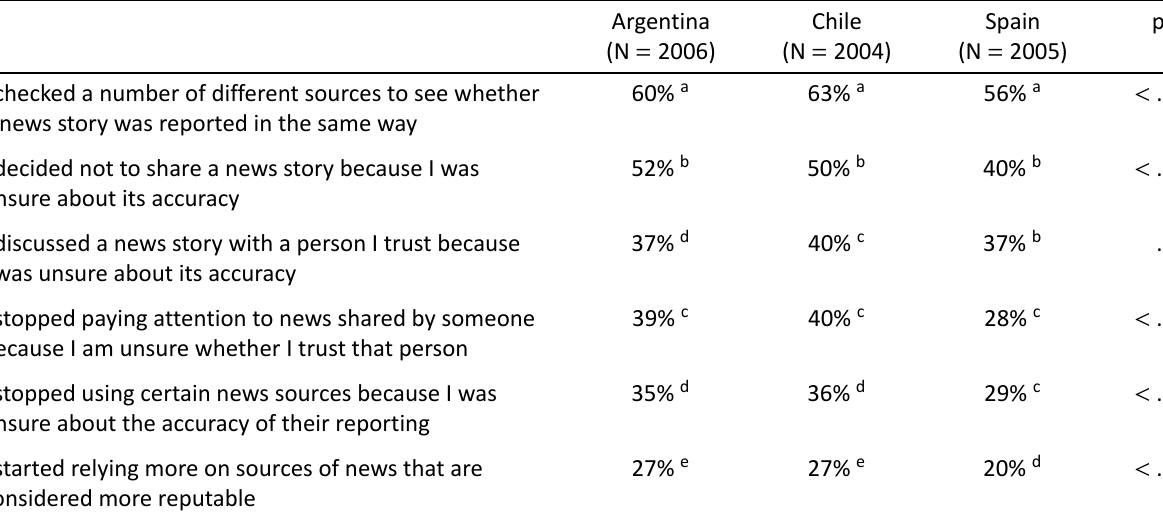
Table 5. Actions against disinformation by